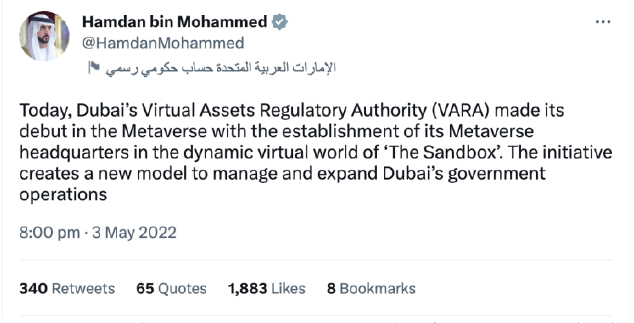
Figure 12: UAE announcing the launch of Metaverse VARA Headquarters